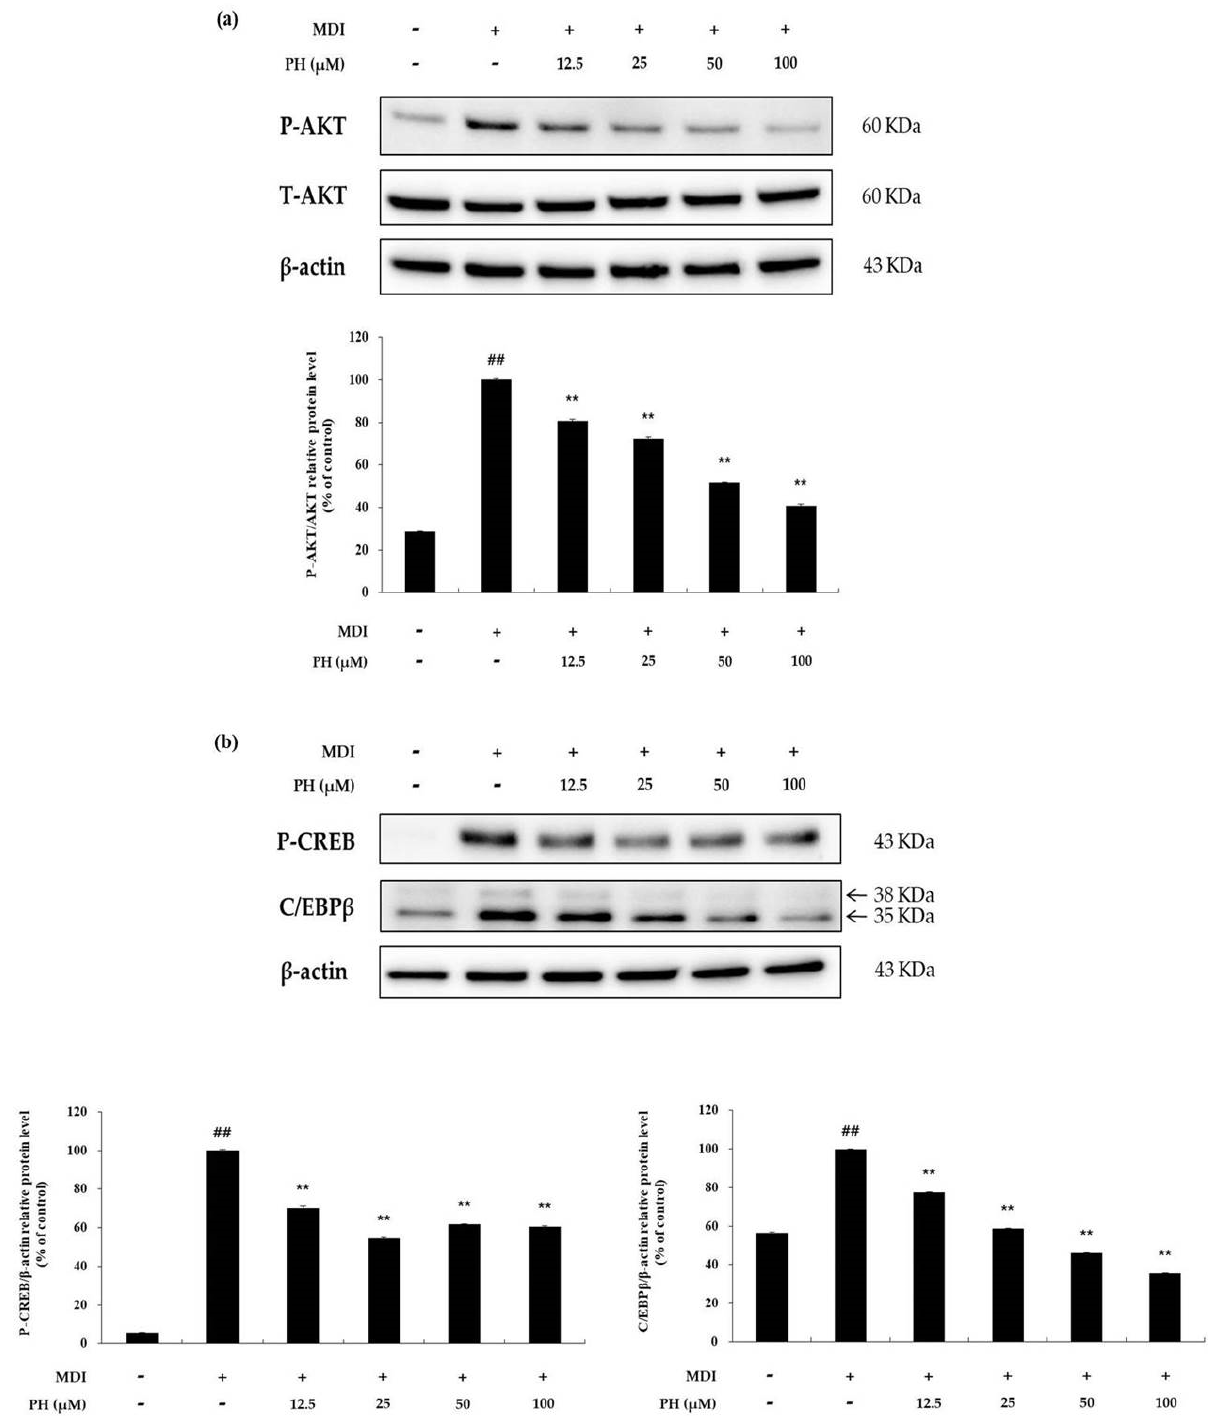
Figure 5. Effect of PH on the AKT-related signaling pathways. Adipocyte differentiation was induced in post-confluent cells using MDI differentiation medium, and the cells were treated with indicated concentrations of PH for 30 min (AKT) and 2 h (P-CREB, C/EBP β ). ( a ) Results of Western blotting and protein levels of P-AKT/AKT and β -actin. ( b ) Results of Western blotting and protein levels of P-CREB, C/EBP β , and β -actin in 3T3-L1 adipocytes. The relative protein levels of P-AKT/AKT, P-CREB/ β -actin, and C/EBP β / β -actin are presented as the mean ± standard deviation of three independent measurements using the ImageJ program. The results in the relative protein levels are expressed as percentages relative to the control cells treated with MDI alone. ** p < 0.01 indicates significant differences versus the MDI-only control. ## p < 0.01 indicates significant differences versus an untreated control.